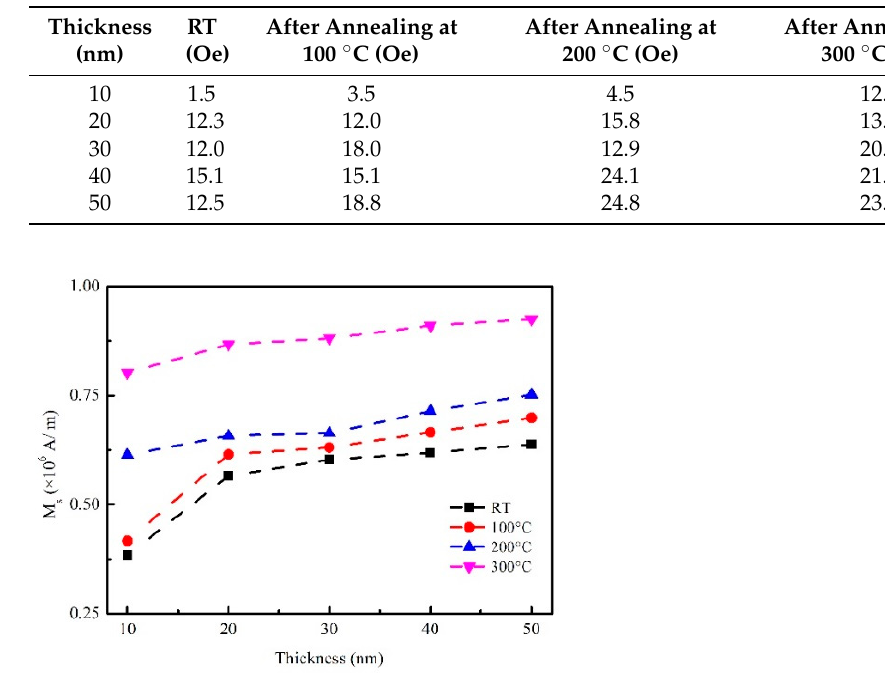
Figure 3. In-plane magnetic hysteresis loop of CoFeBY nanofilms: ( a ) RT, ( b ) after annealing at 100 °C, ( c ) after annealing at 200 °C, ( d ) after annealing at 300 °C. Table 1. Coercivity (H c ) of CoFeBY nanofilms.